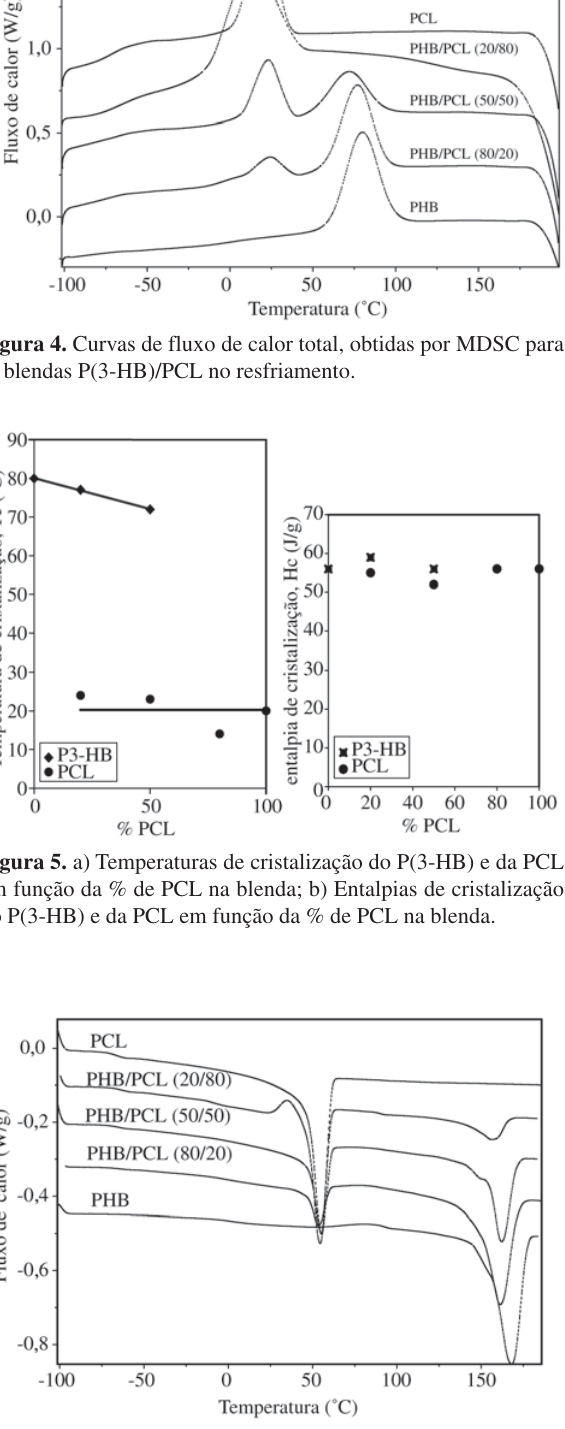
Figura 6. Curvas de fluxo de calor total, obtidas por MDSC para as blendas P(3-HB)/PCL no segundo